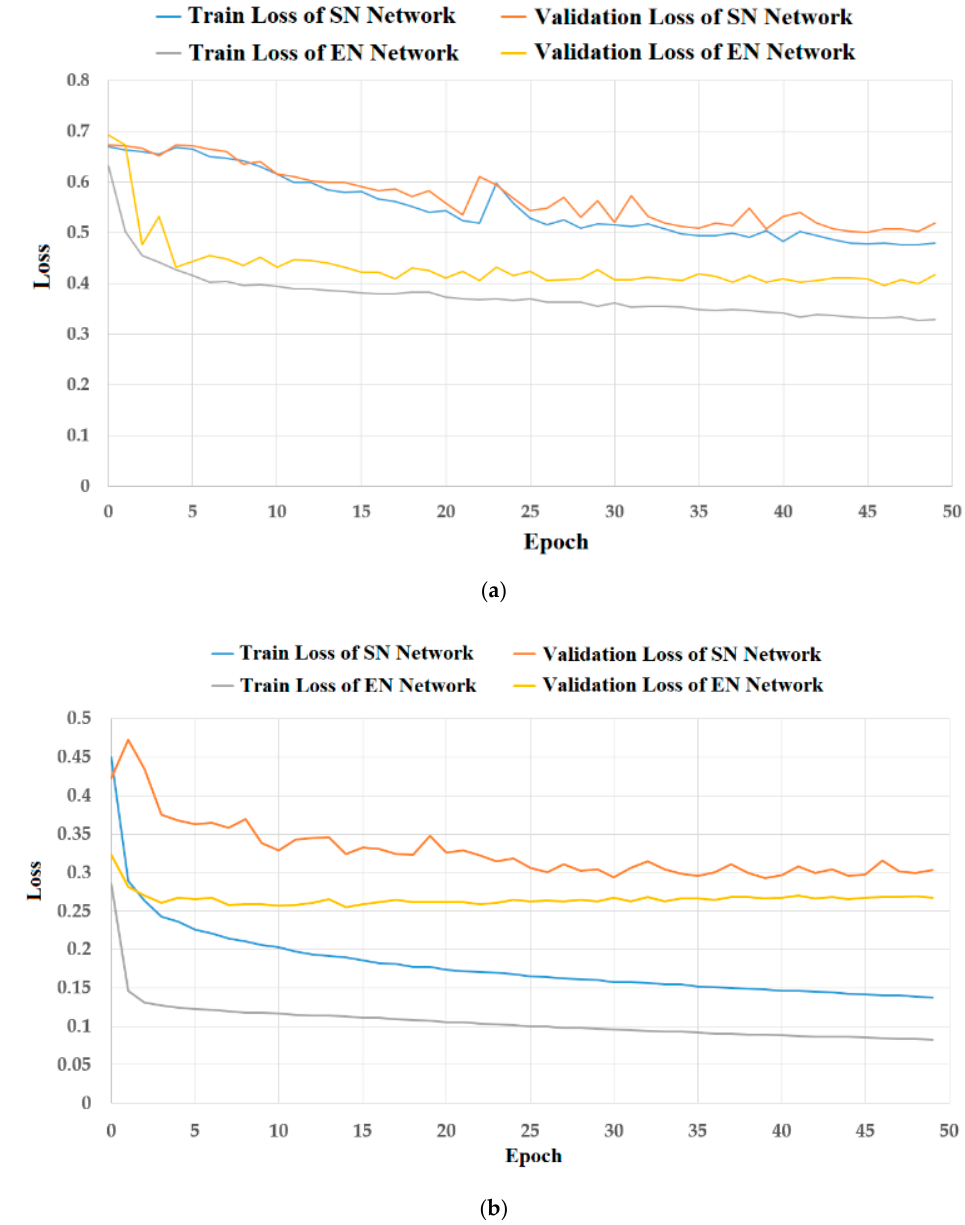
Figure 8. Training results (loss curves) of the SNs and ENs on the ( a ) TDID dataset, and ( b ) 3DThyroid